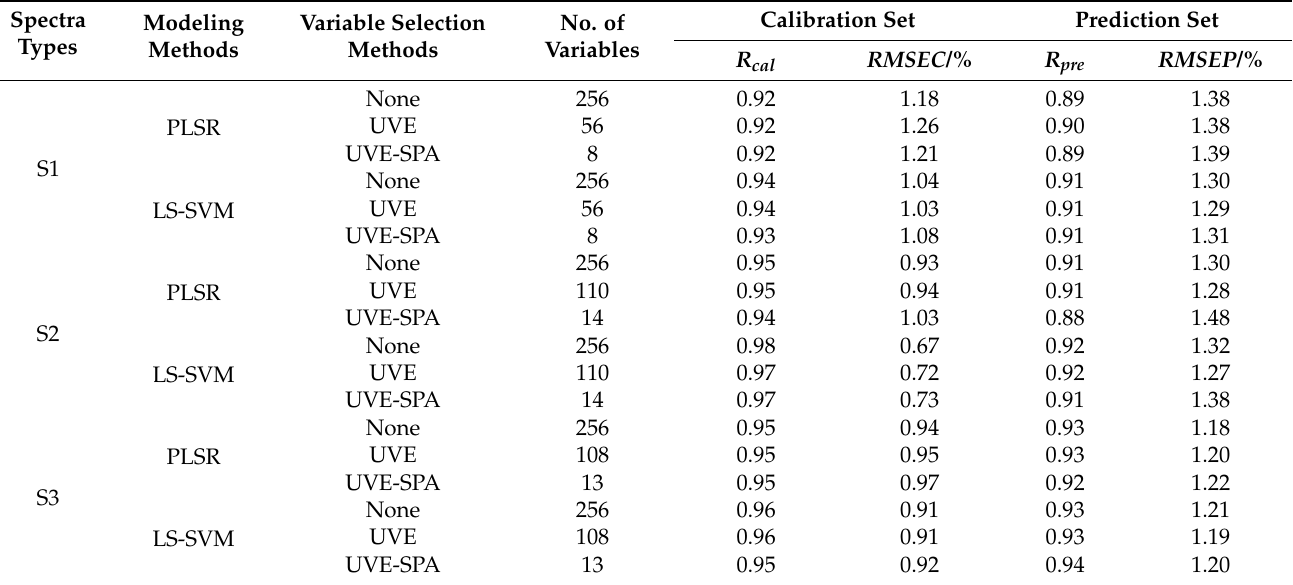
Table 3. The results of MC prediction based on PLSR and LS-SVM models with different